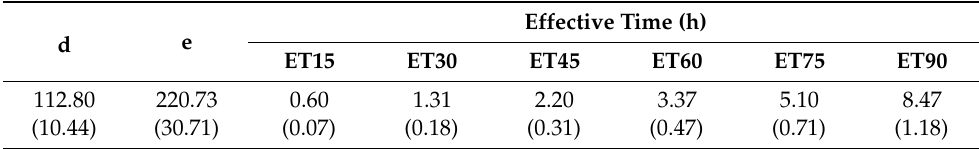
Table 4. Parameters of the non-linear asymptotic regressions (Equation (1)) and effective times of the autonomous mower estimated from the two-stage meta-analysis dose-response model for an area of 740 m 2